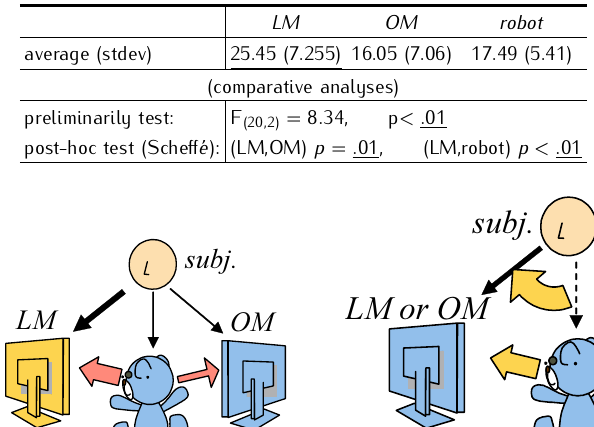
Table 3. Total Gazing Duration of Subjects in Each Direction